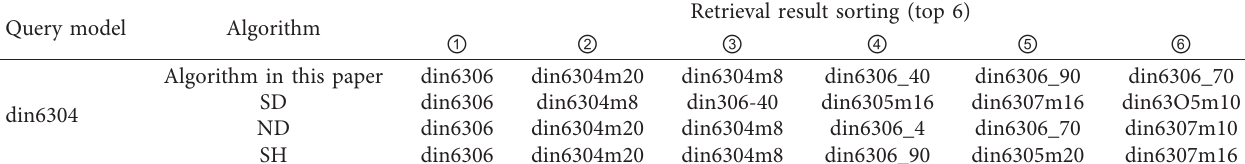
Table 1: Retrieval results of four algorithms for T -shaped parts model.